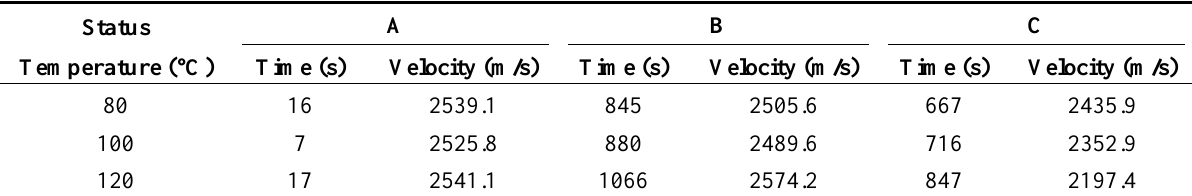
Table 1. Ultrasonic velocities and times for the three processing statuses under the temperature settings of 80, 100 and 120